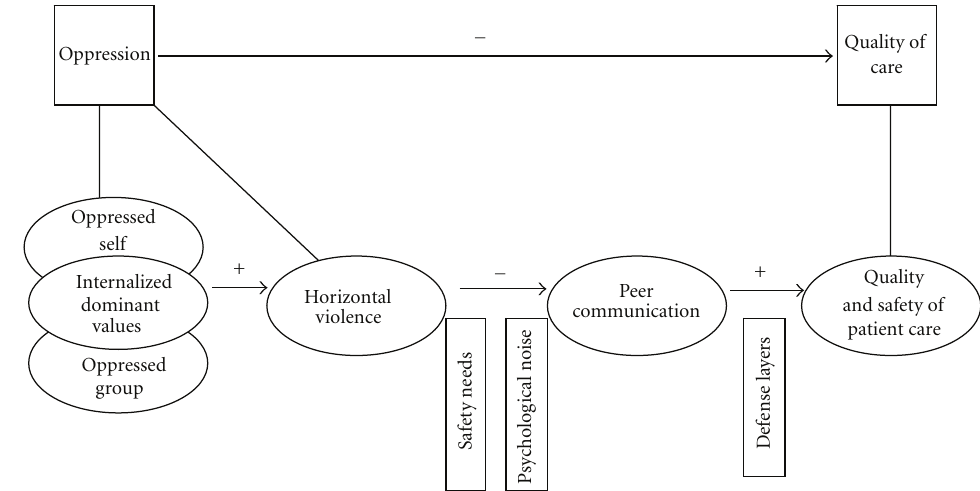
Figure 1: A conceptual model for horizontal violence and the quality and safety of patient